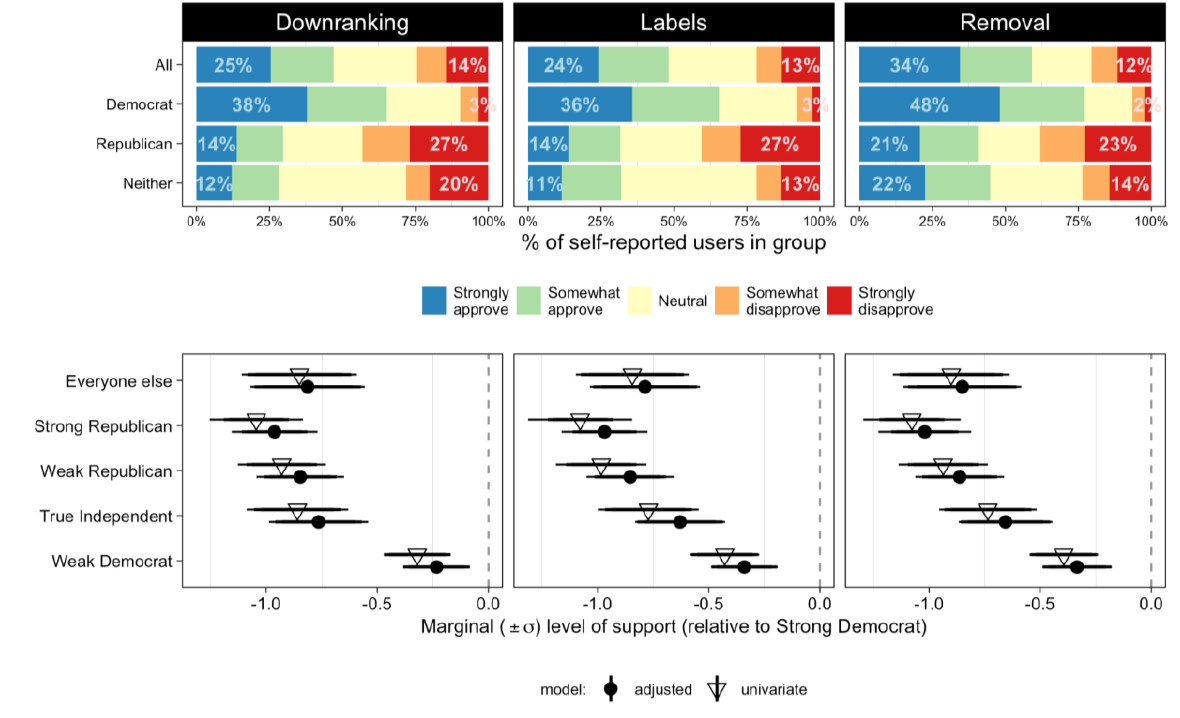
Figure 4. Support for specific misinformation interventions by party. The top grid of plots shows percentage ( x- axis) of responses in each approval category (colored bars) for each respondent group (rows) and intervention type (columns) . The “Neither” category inclu des True Independents (identified via an explicit response), non-responders, and third-party affiliates. The bottom row of plots shows estimated standardized differences in the level of approval between the different partisan groups using a simple t -test (univariate model) as well as a battery of controls (adjusted